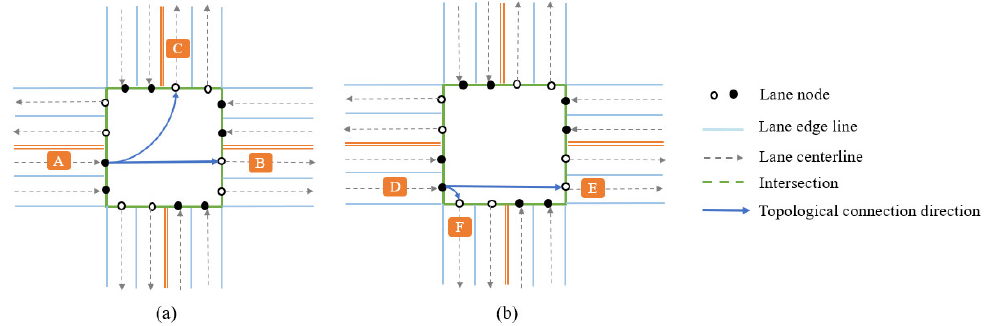
Figure 12. Lane-level topological relationship at an intersection. (a) Topological relationship of lane A; (b) Topological relationship of lane D.